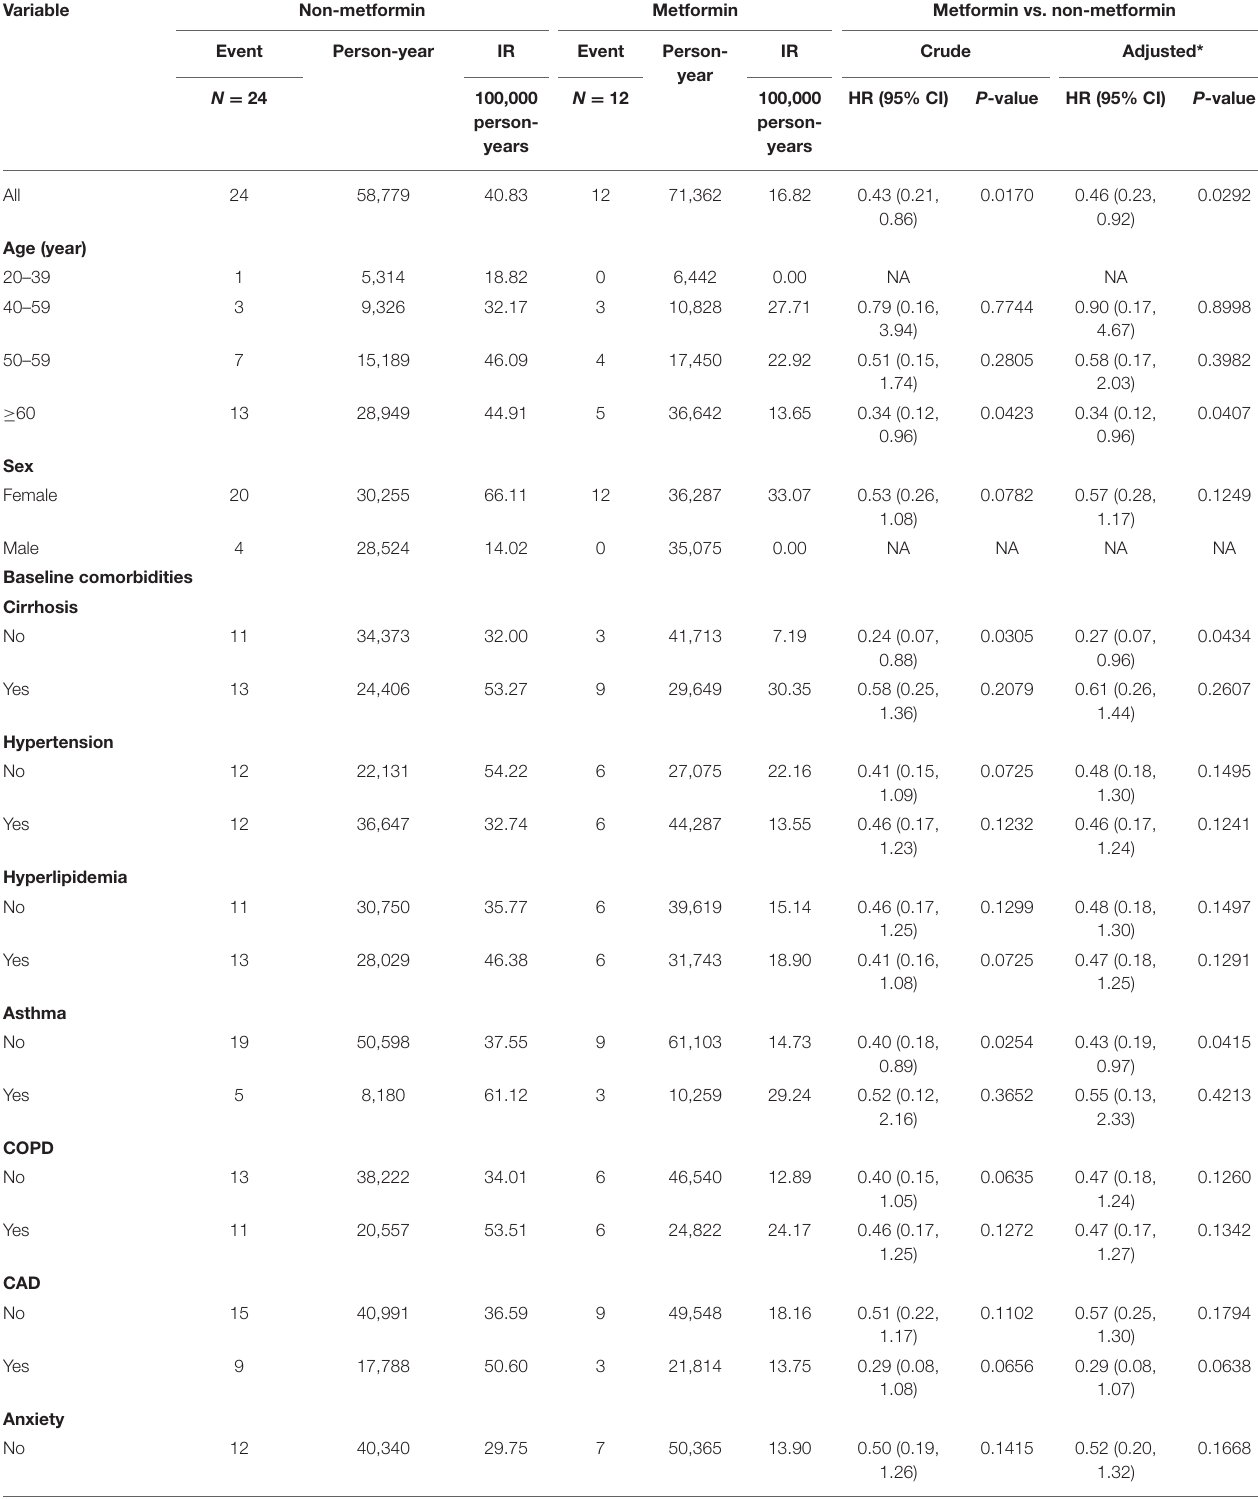
TABLE 3 | Comparisons of incidence of Sjögren’s syndrome in type 2 diabetic patients with and without metformin stratified by demographics, baseline comorbidities, and other anti-diabetic drugs. Variable